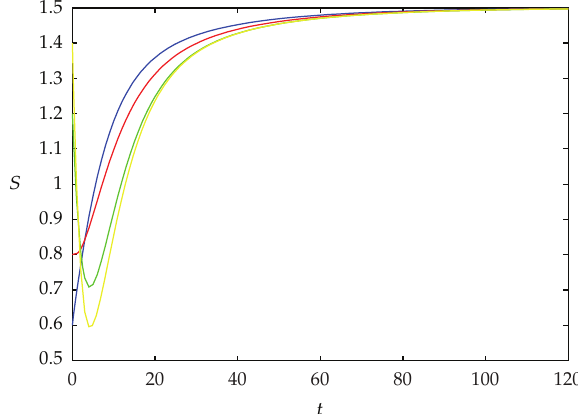
Figure 1: Time series of S (cid:3) t (cid:4) with di ff erent initial values and parameters ρ (cid:7) 0 . 3 , μ (cid:7) 0 . 2 , β (cid:7) 1 . 5 , α (cid:7) 1 , r (cid:7) 0 . 5 , d (cid:7) 0 . 2 , ω (cid:7) 0 . 1 , and τ (cid:7)